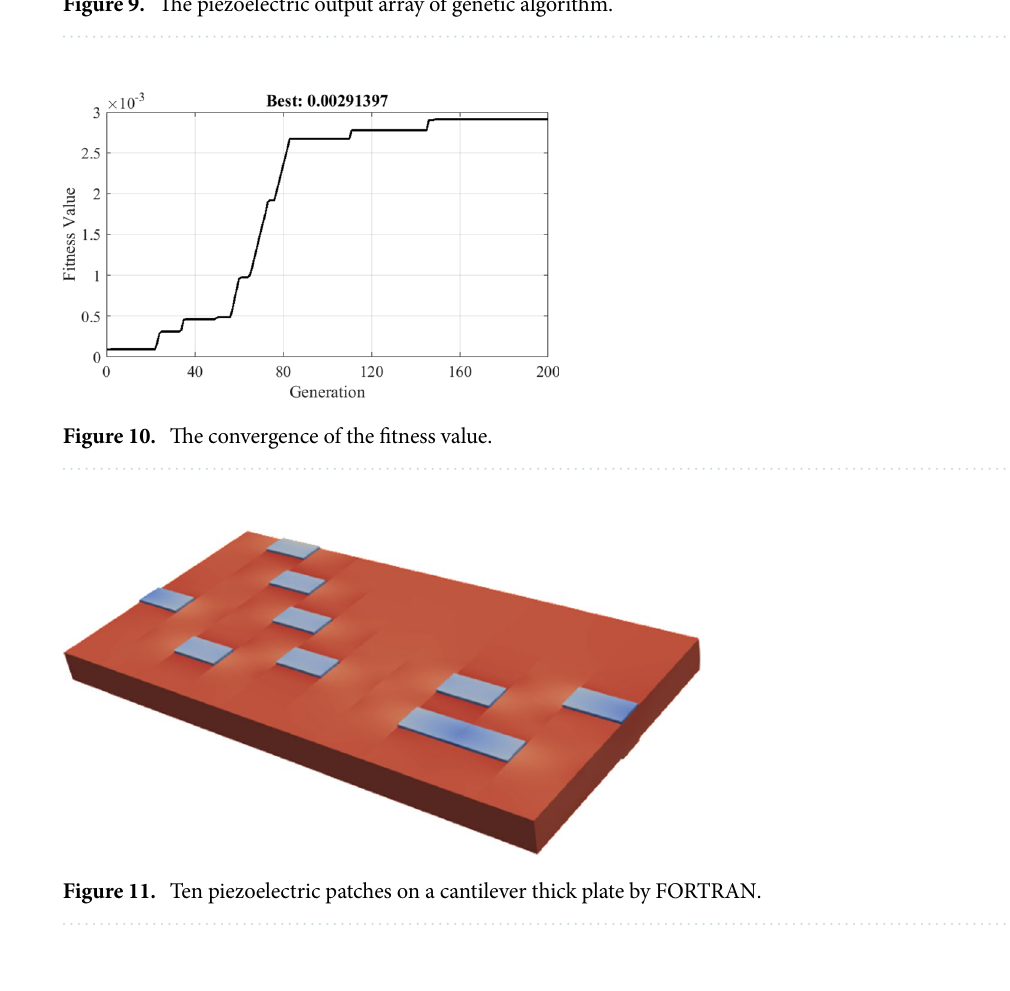
Figure 9. The piezoelectric output array of genetic algorithm.